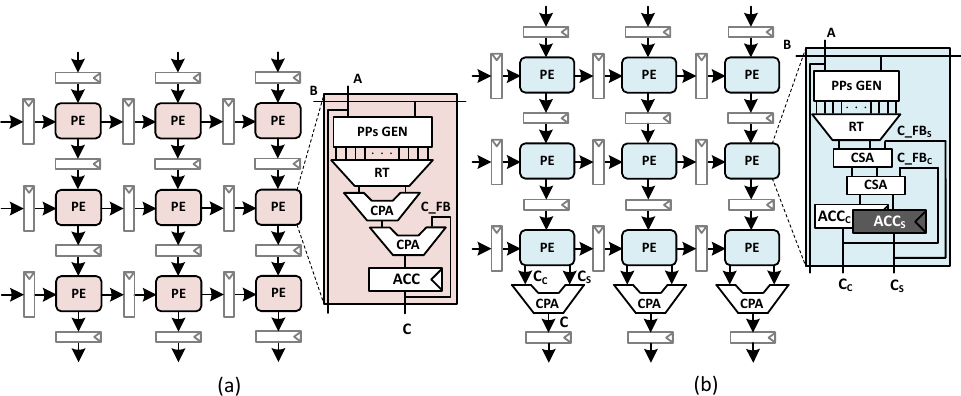
Figure 1. ( a ) Conventional systolic array (SA) architecture (i.e., Gemmini SA). ( b ) Proposed carry propagation adder (CPA)-factored systolic array architecture. The systolic architecture with the output stationary dataflow allows us to store the partial sum in a PE in the carry save representation and to convert it into the binary form at the column